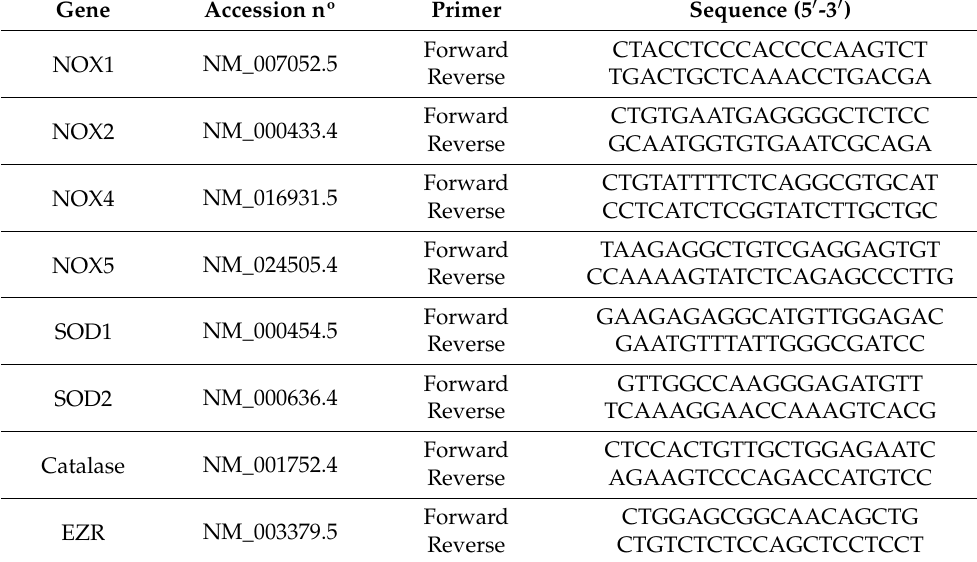
Table 1. Primers used for specific gene expression quantification by